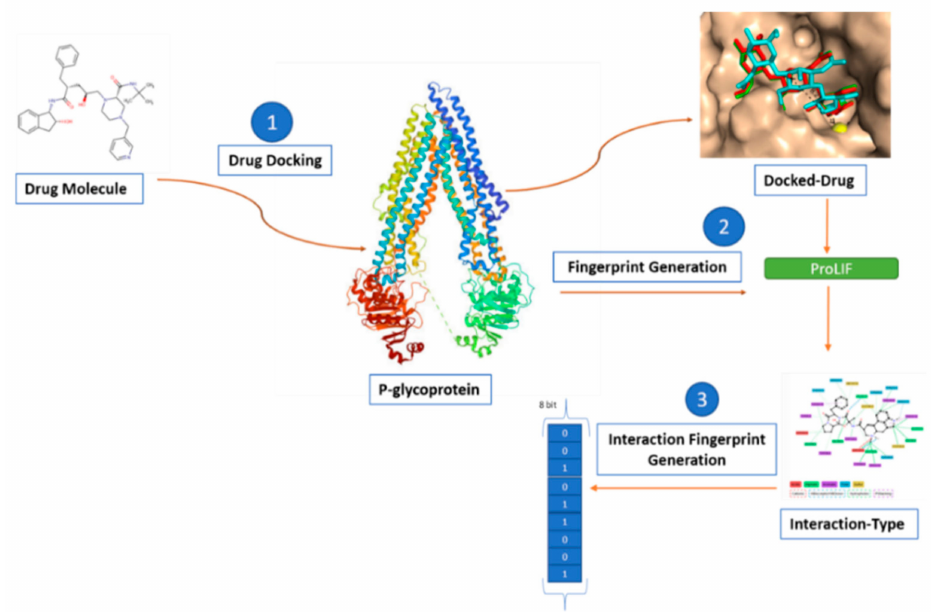
Figure 3. Interaction-type pharmacophore fingerprint: DockedFP(1b). (1) Standardized and stabilized drug molecules are docked with the P-gp receptor. (2) The docked drug data and P-gp receptor are imputed in the ProLIF library. (3) Data are processed using the default distance boundaries given for different interaction types and, finally, the 9-bit fingerprint is